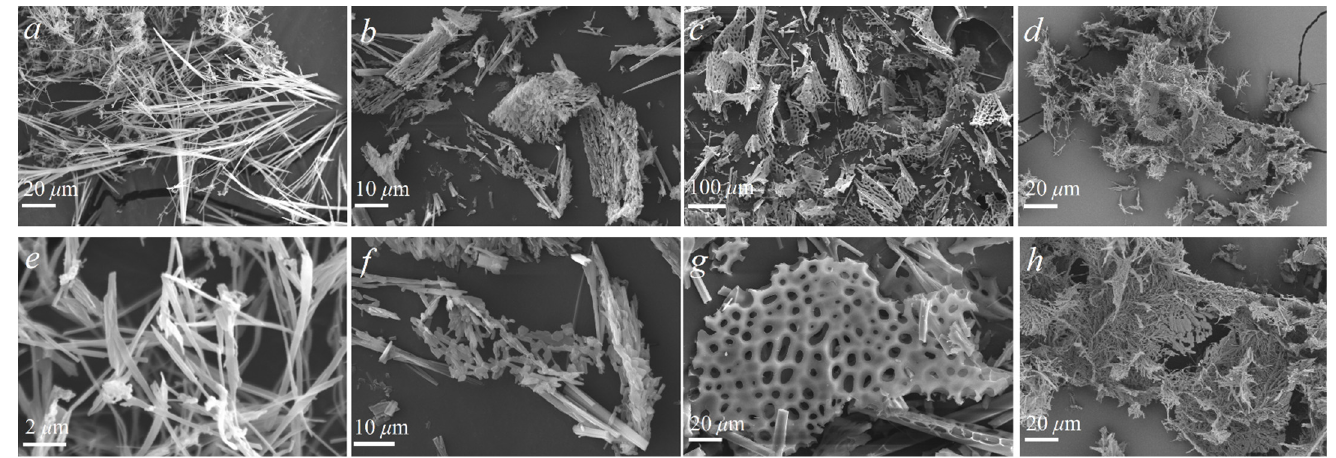
Figure 1. SEM images of ultrafine Pz ( a , e ) Pz formulations with mannitol ( b , f ), trehalose ( c , g ), and glycine ( d , h ).